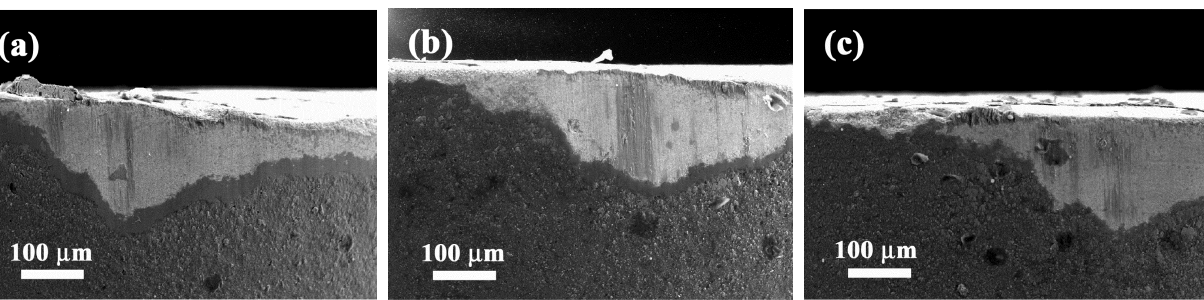
Figure 7. Maximum flank wear depths of uncoated, TiN, TiAlN, and (Al 0.34 Cr 0.22 Nb 0.11 Si 0.11 Ti 0.22 ) 50 N 50 coated inserts milling against SKD11 steel as a function of cutting distance in the interrupted milling test.